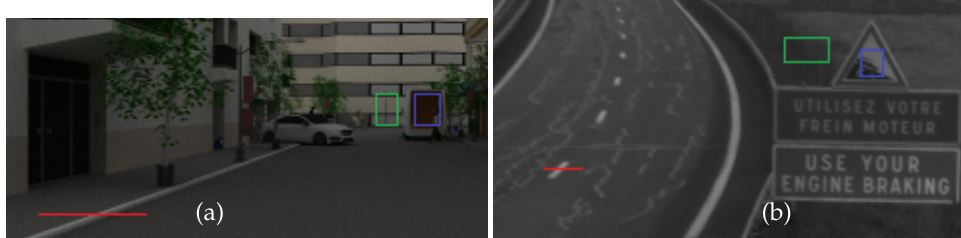
Figure 11. Pixel lines (in red) and contrast polygons (in blue/green) for the urban simulated scene ( a ) and the real one from a section of the French A75 highway (at the Col de la Fageole point) ( b